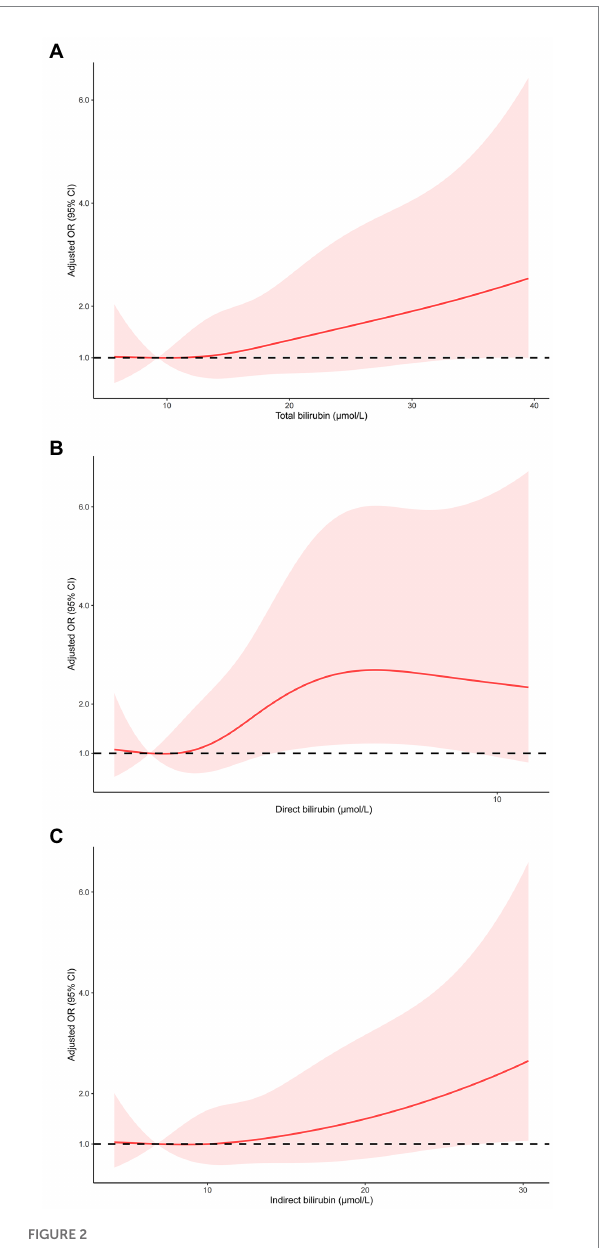
FIGURE 3 Restricted cubic spline regression models of the relationship between serum bilirubin levels and the risk of sICH. Total bilirubin ( A ), direct bilirubin ( B ) and indirect bilirubin ( C ). The model was adjusted for the same confounding variables as in multivariable logistic regression model. sICH, symptomatic intracranial